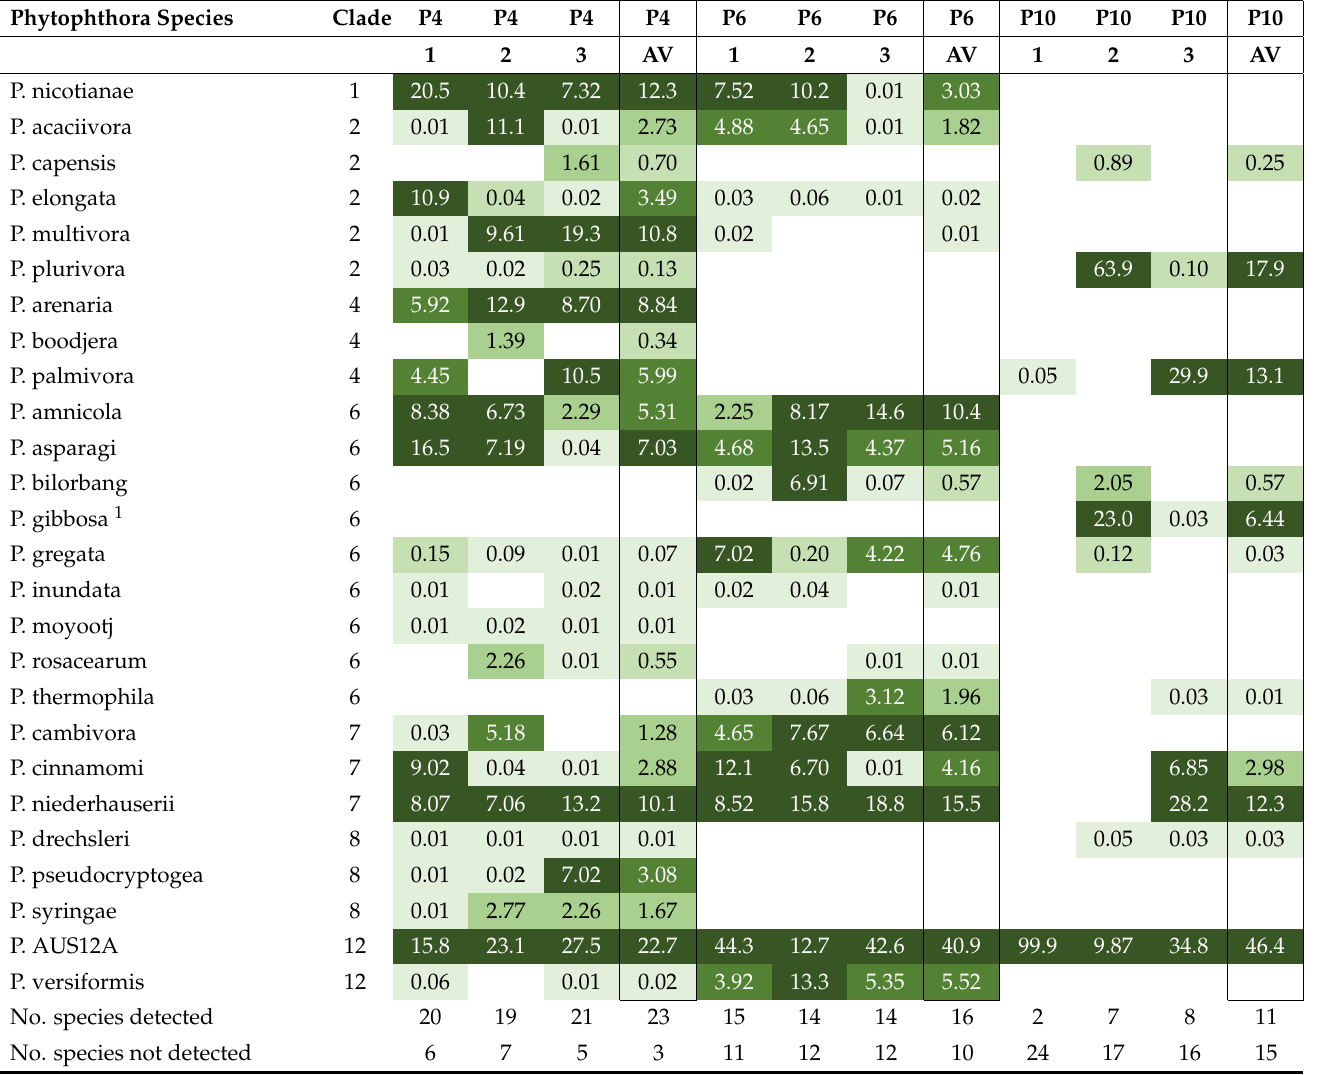
Table 4. Percentage of the total number of reads of each Phytophthora species detected for three technical replicates of environmental sample E3 amplified with primers P4, P6, and P10. The average percent of reads is also given (AV). Cells are colour-coded, as per Figure